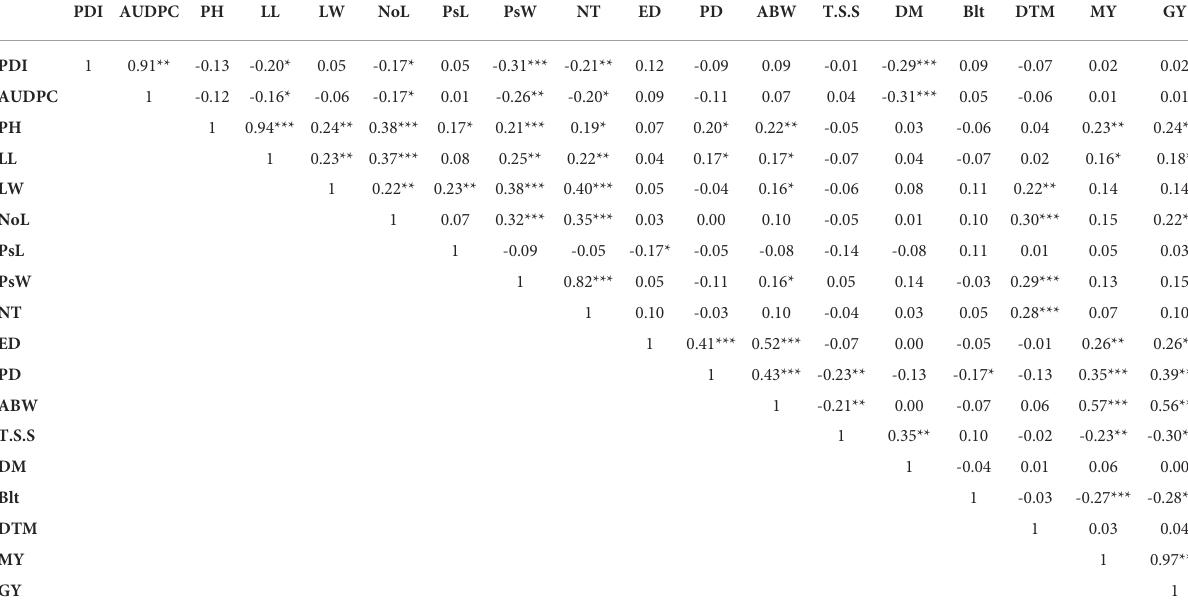
TABLE 4 Pearson ’ s correlation coef fi cient of PDI with morphological and biochemical traits.